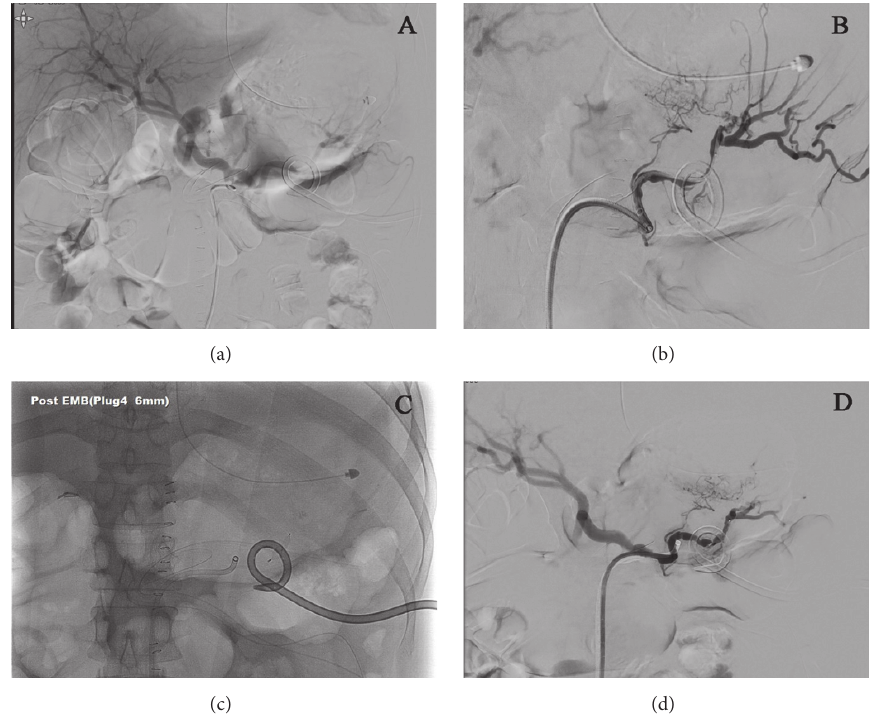
Figure 3: (a and b) Celiac and splenic arteriography showed no extravasation from arterial system. (c) Nonselective splenic artery embolization was performed using vascular plug at distal splenic artery. (d) After embolization, blood flow to spleen was remarkably decreased.